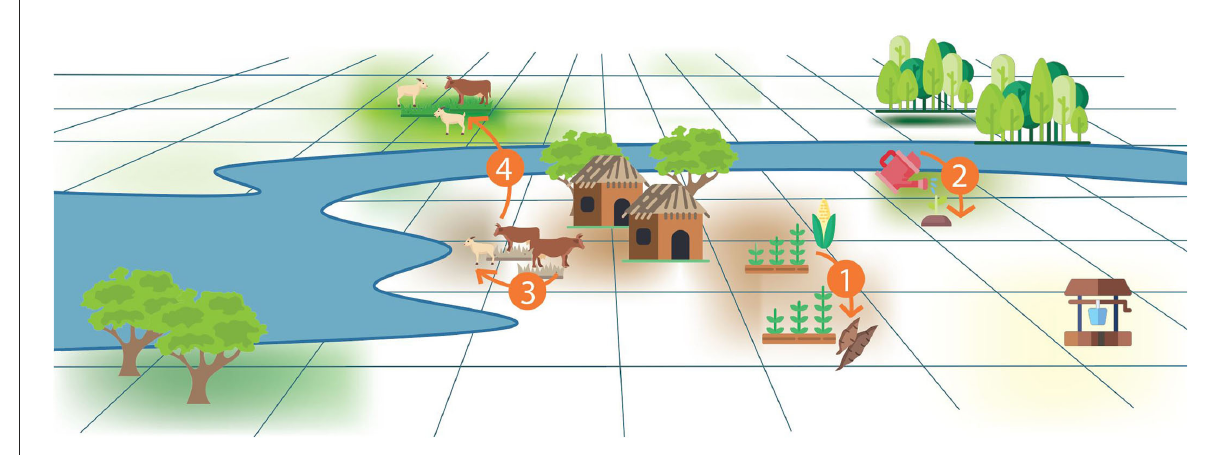
FIGURE3 Adaptation measures modeled in ADOPT-AP. 1. Change crop types. 2. Apply irrigation. 3. Change livestock types. 4. Migrate livestock.